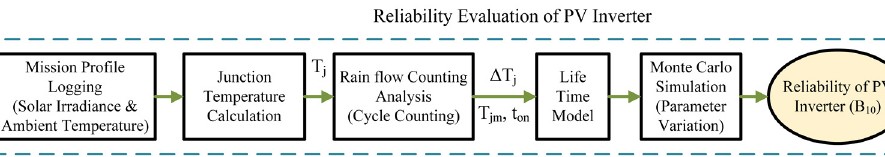
Figure 1. Flow chart for reliability analysis.